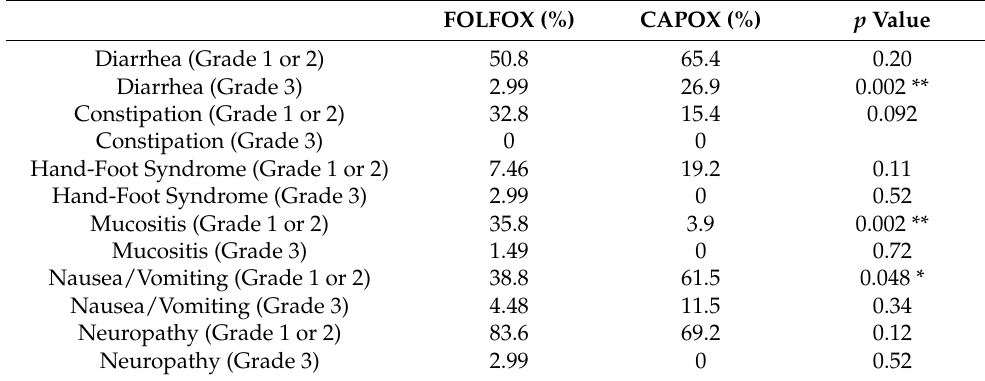
Table 2. Patient Toxicities Secondary to Adjuvant Treatment with FOLFOX or